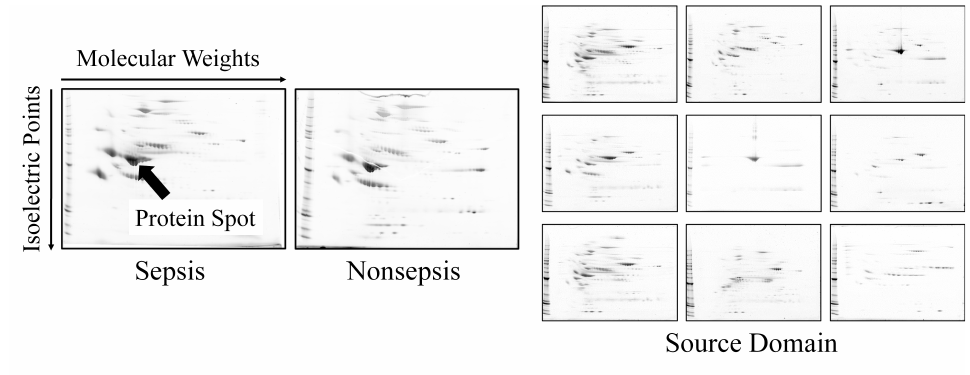
Figure 4. Examples of 2-DE images. X- and Y-axes represent molecular weights and isoelectric points, respectively, and black regions represent protein spots. The position of the same protein is approximately the same for each patient because each axis represents an absolute physical quantity.